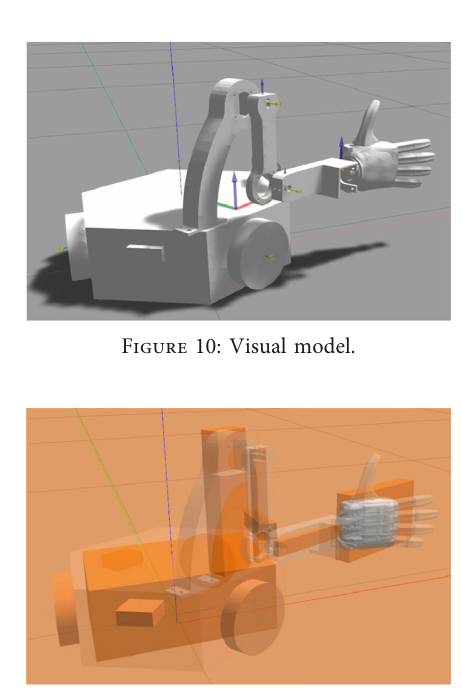
Figure 11: Collision